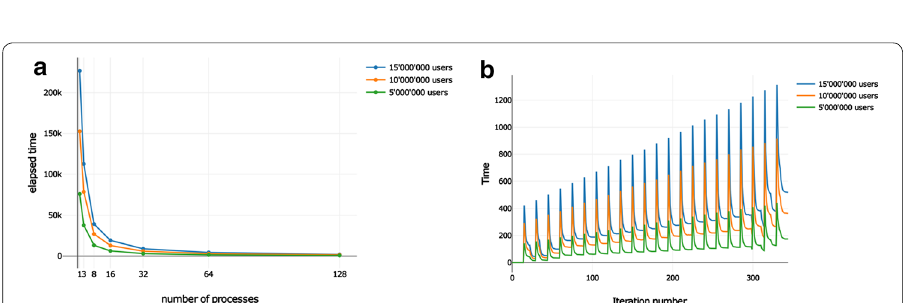
Fig. 13 Simulation time as a function of a number of processes, b iteration number (for 3